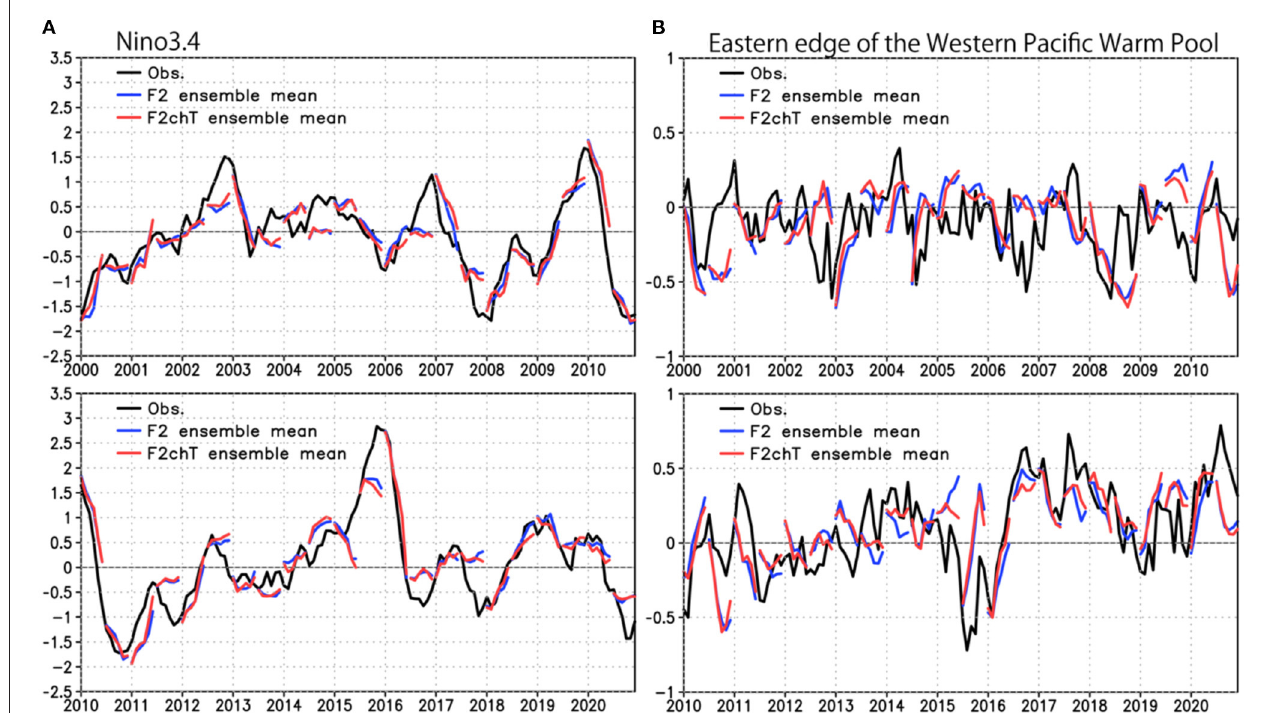
FIGURE 2 | (A) Monthly time series of the Niño3.4 Index ( ◦ C) from the observational data (black) and the predictions (12-ensemble mean) issued on January 1 st and July 1 st by F2 (blue) and F2chT (red). (B) Same as (A) , but for the eastern edge of the Western Pacific Warm Pool (140 ◦ E − 160 ◦ E, equator − 10 ◦